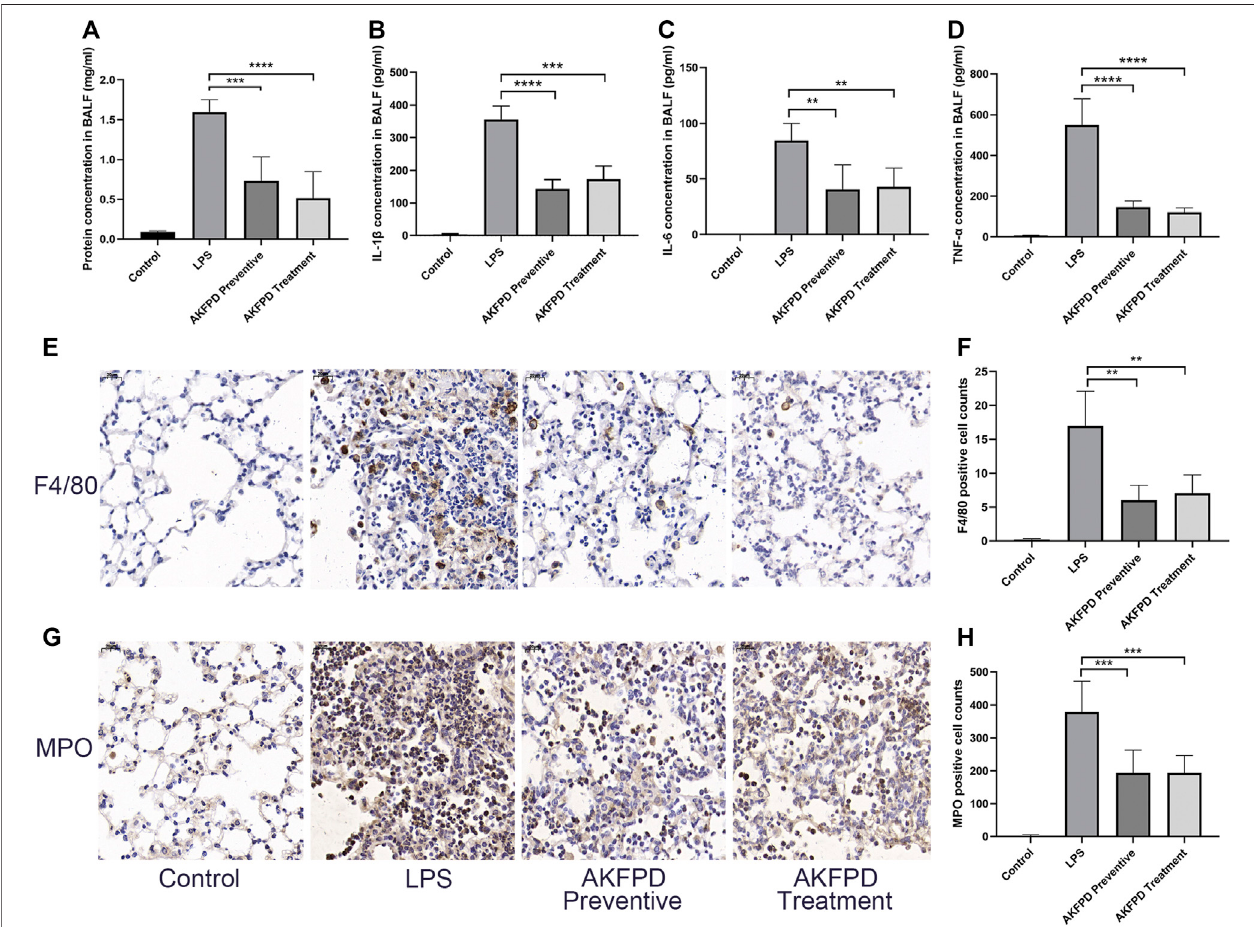
FIGURE2| Fluorofenidonedecreasedthepulmonaryin fl ammationintheLPS-inducedmousemodel. (A) ConcentrationoftotalproteininBALF. (B – D) Expression of IL-1 β , IL-6, and TNF- α levels in the BALF of mice. (E – H) Immunohistochemical staining of F4/80, MPO, and positive cell count analysis in the lung tissue of different groups of mice. Scale bar (cid:1) 20 μ m. Data were represented as mean ± SD. n (cid:1) 6 per group. ** p < 0.01, *** p < 0.005, and **** p < 0.001 vs. LPS group.